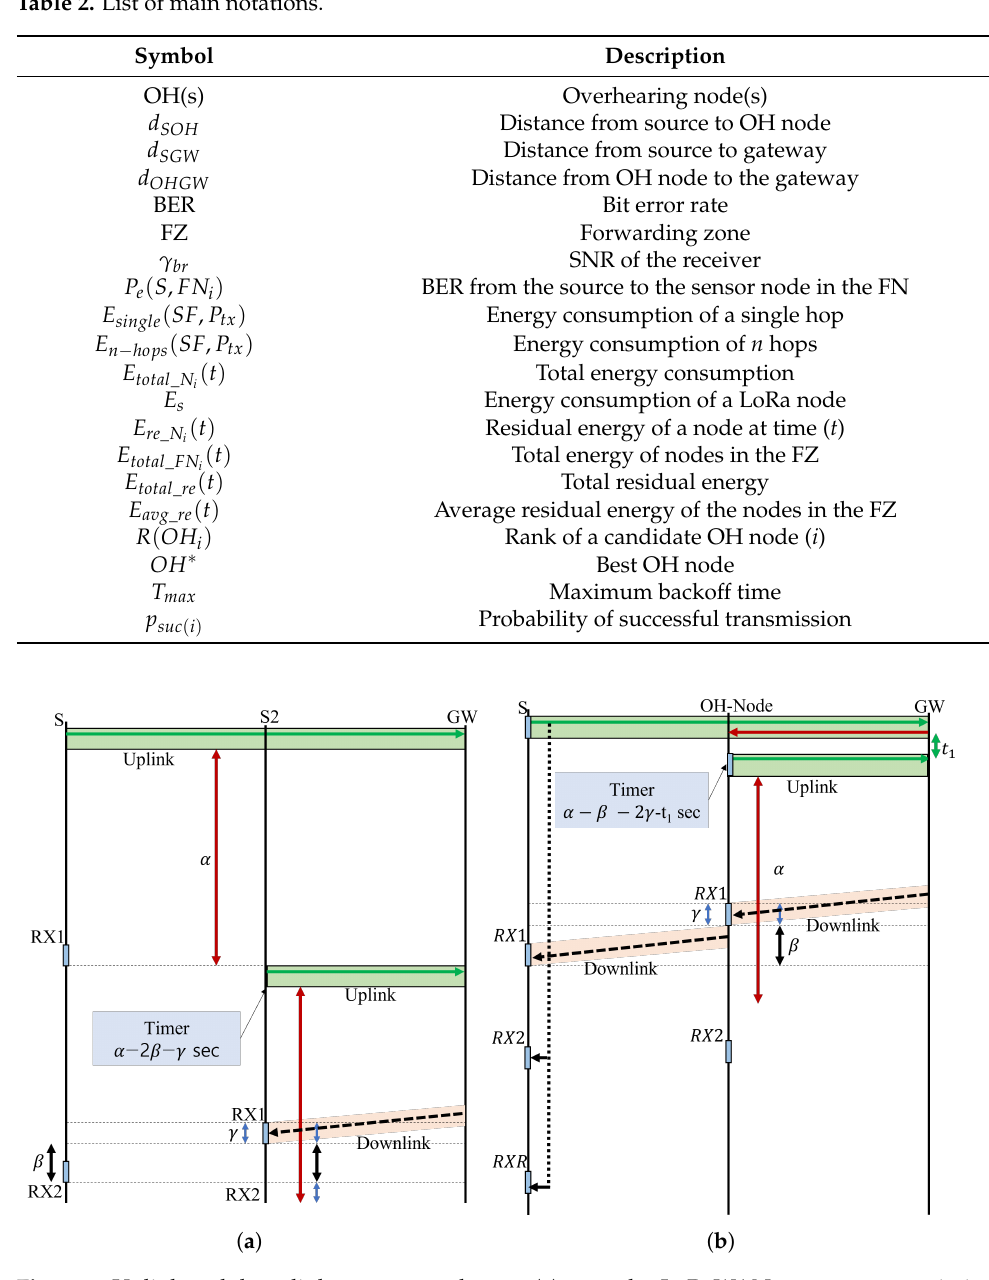
Figure 3. Uplink and downlink message exchange: ( a ) a regular LoRaWAN message transmission; ( b ) IOMC message forwarding